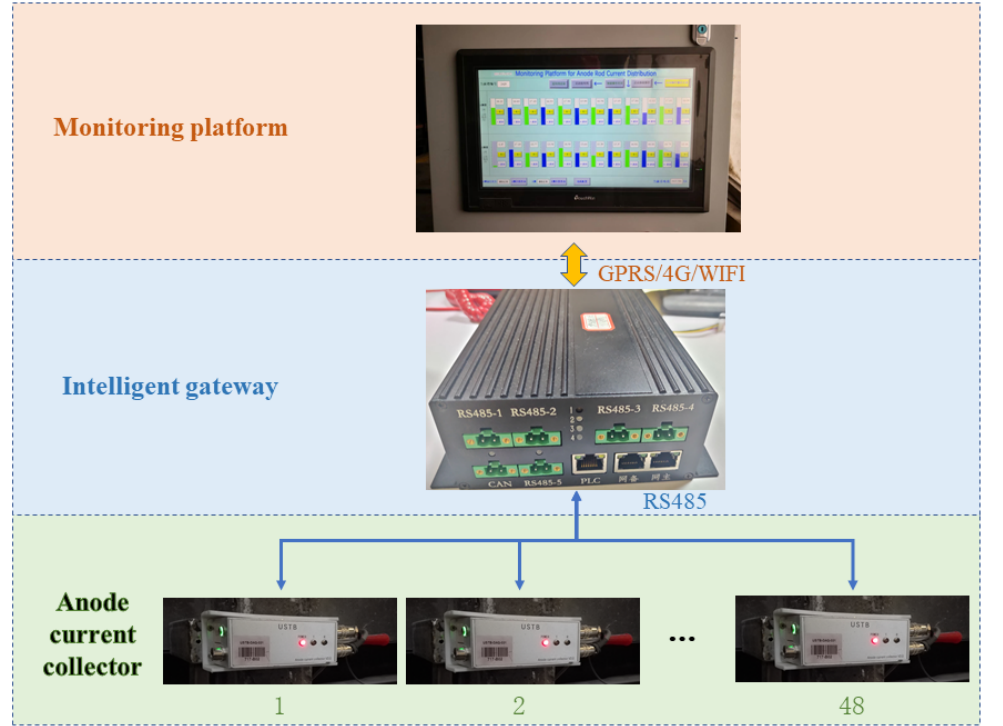
Figure 8. Block diagram of distributed anode rod current monitoring system for aluminum reduction Cells.